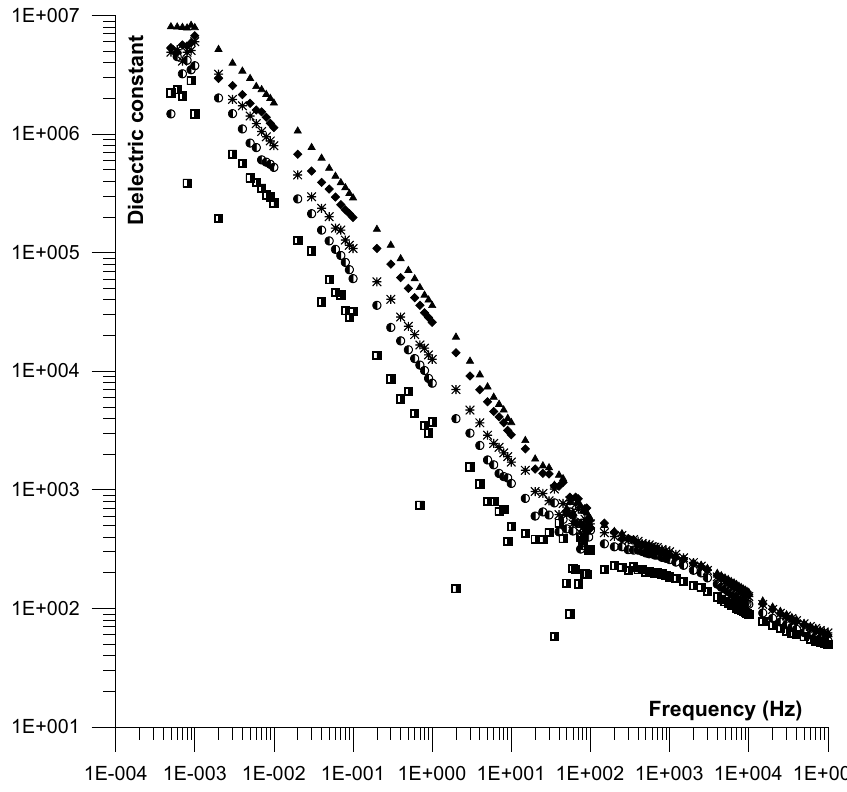
Fig. 4 Variation of the dielectric loss with frequency for Aswan iron ore deposits, for samples 1 ( ) , 2 ( ) , 3 ( ) , 4 ( ) and 5 ( ) ,